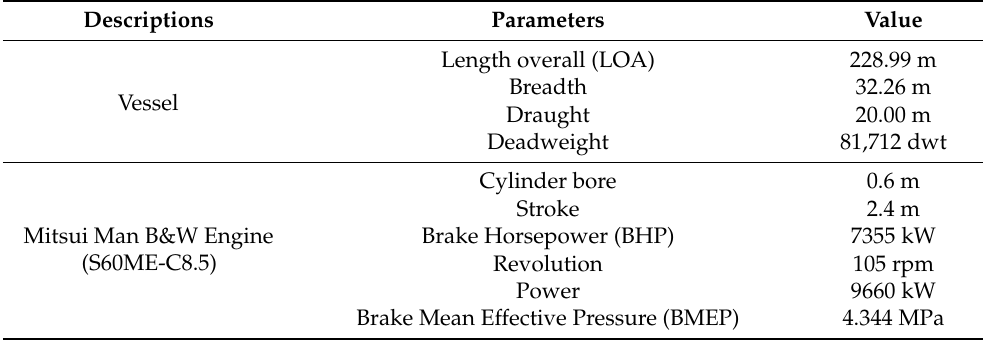
Table 1. Bulk carrier parameters.